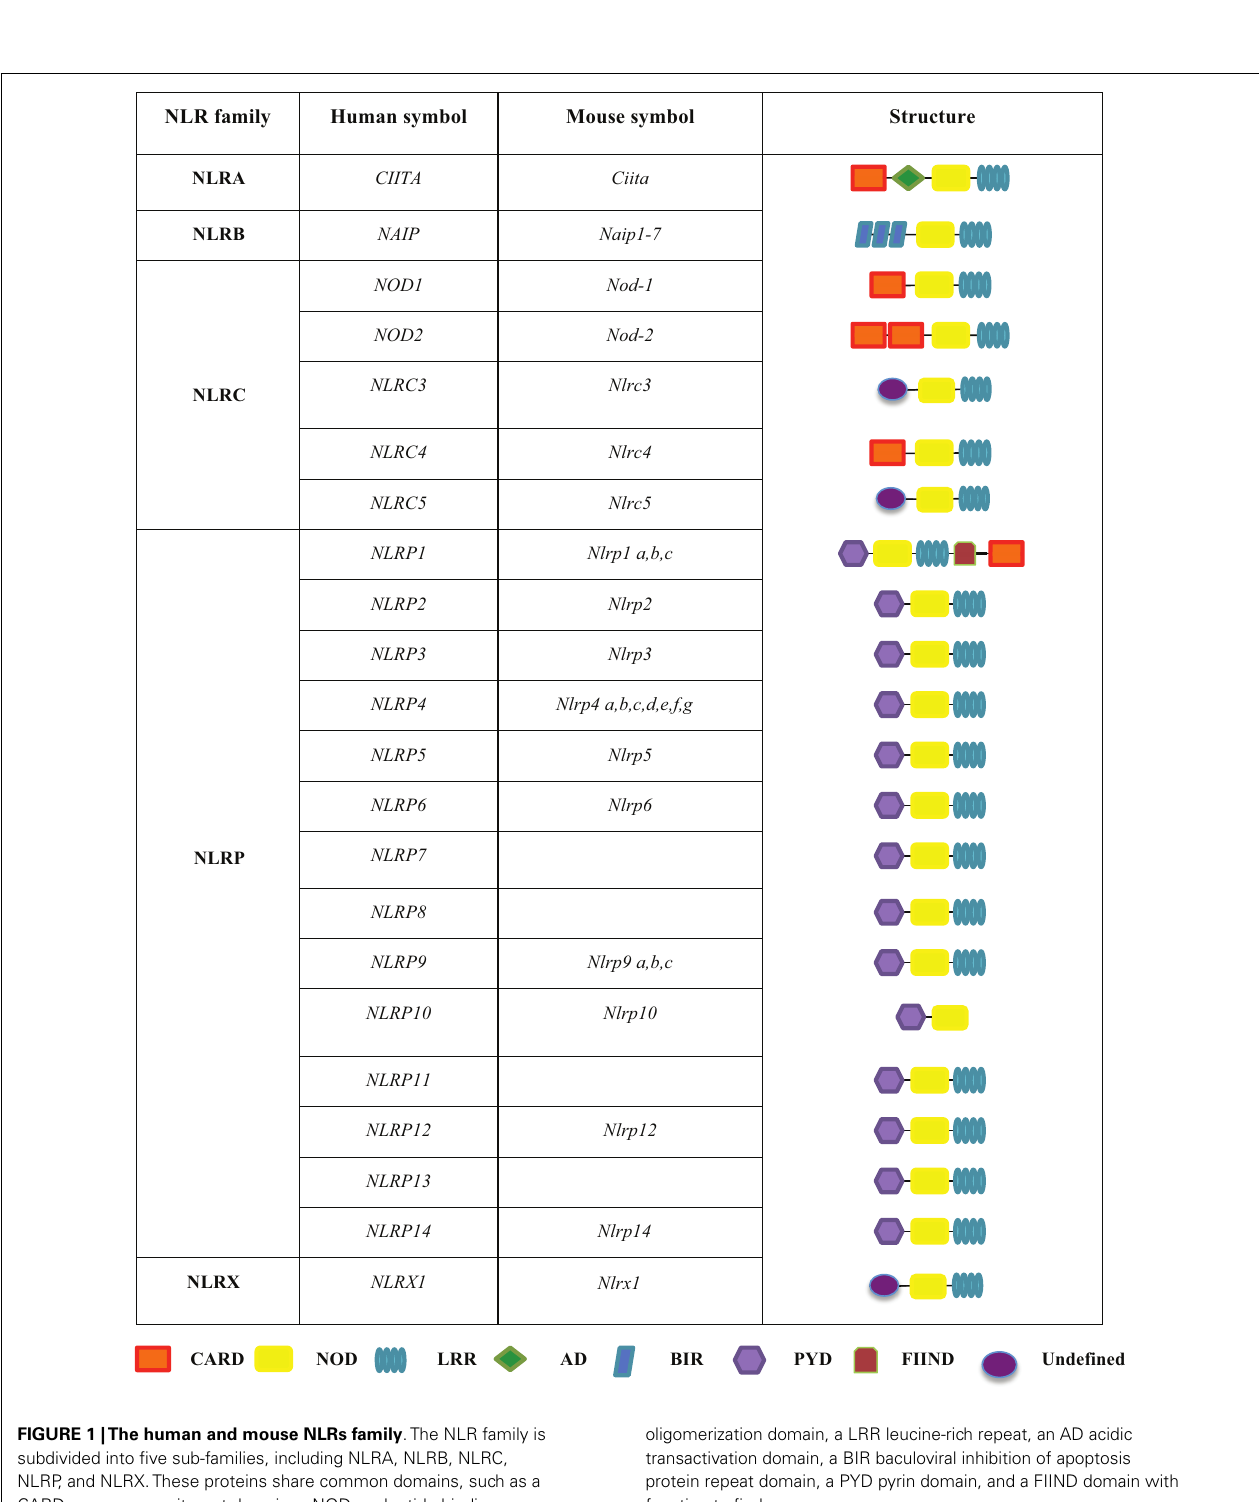
FIGURE 1 |The human and mouse NLRs family .The NLR family is subdivided into five sub-families, including NLRA, NLRB, NLRC, NLRP, and NLRX.These proteins share common domains, such as a CARD caspase recruitment domain, a NOD nucleotide-binding